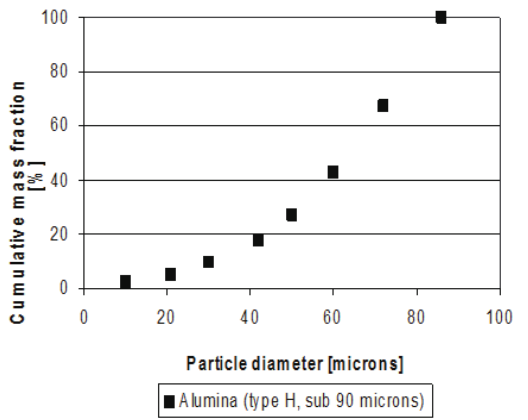
Fig. 5 Alumina fraction less than 90 microns.